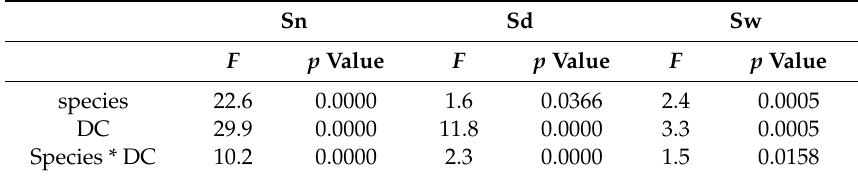
Table 3. Summary of generalized linear model (GLM) analysis of the e ff ect of the wood species and decay classes on the water storage